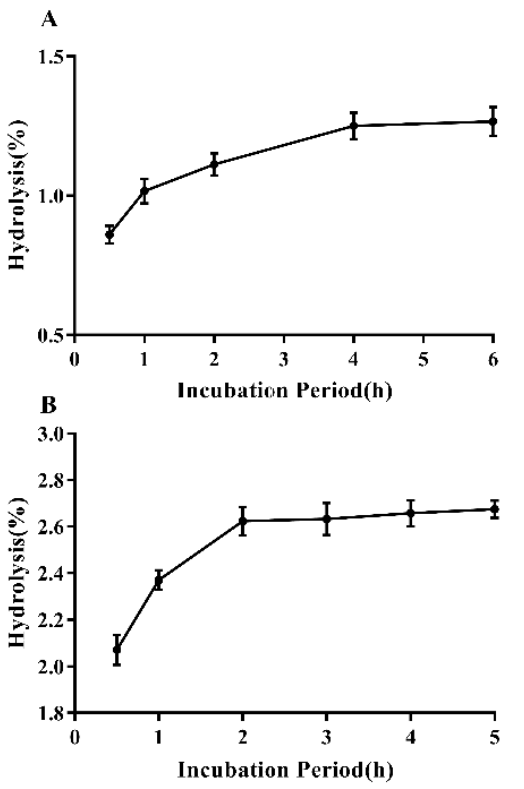
Figure 10. Hydrolysis of Lpb. plantarum NMGL2 EPS in simulated human digestive juice: ( A ). Gastric juice; ( B ). Intestinal juice.